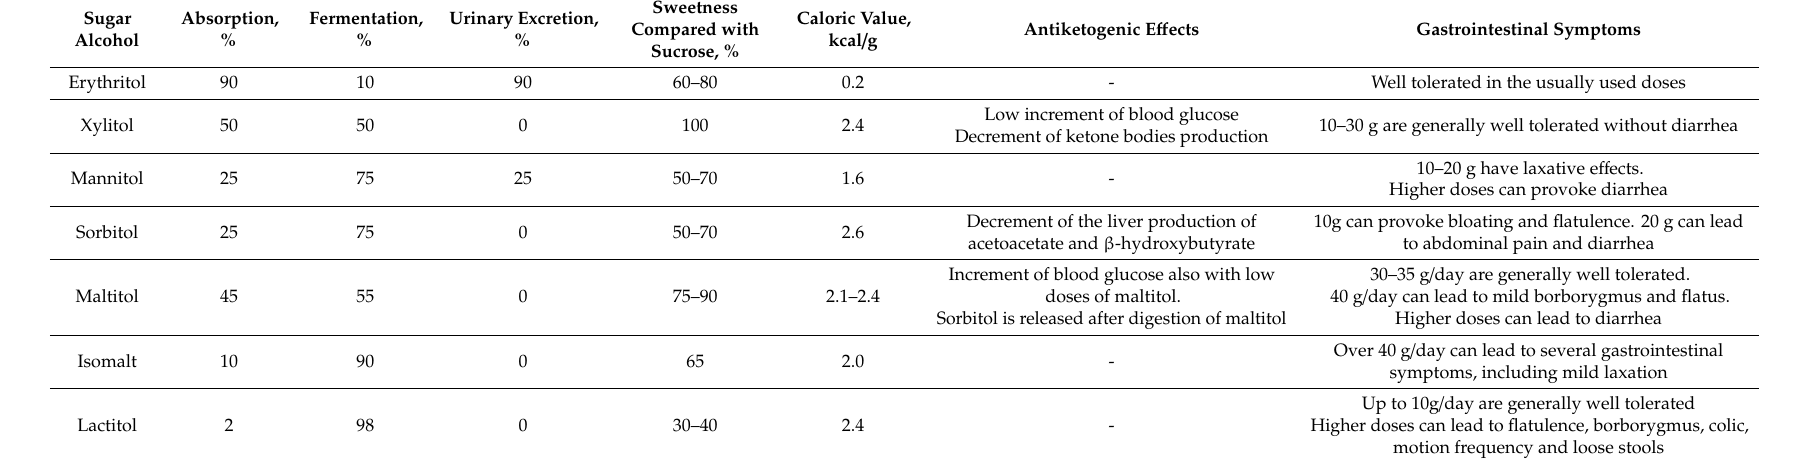
Table 2. Characteristics and properties of the most used